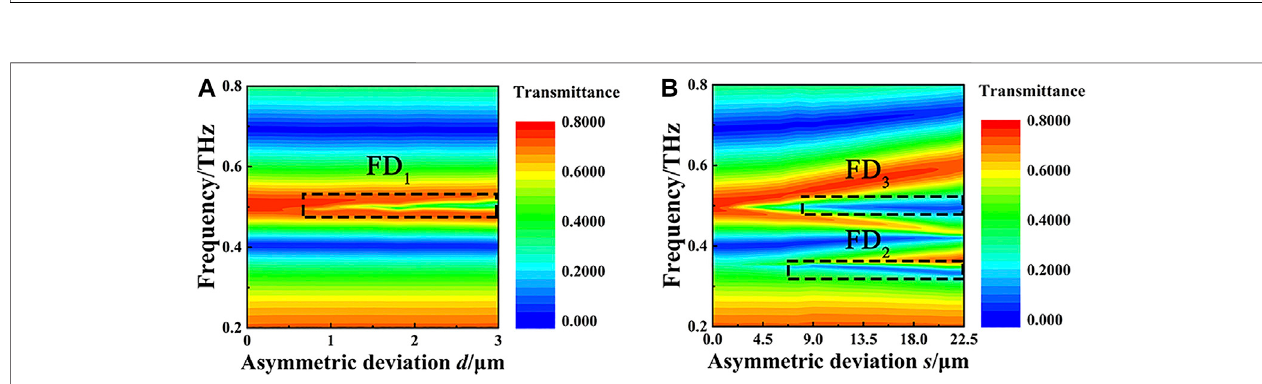
FIGURE2|(A) TransmittancespectraofMM-1(blackline),MM-2(redline),andMM-3(blueline).Surfacecurrent (top) andelectric fi elddistribution (bottom) at (B)